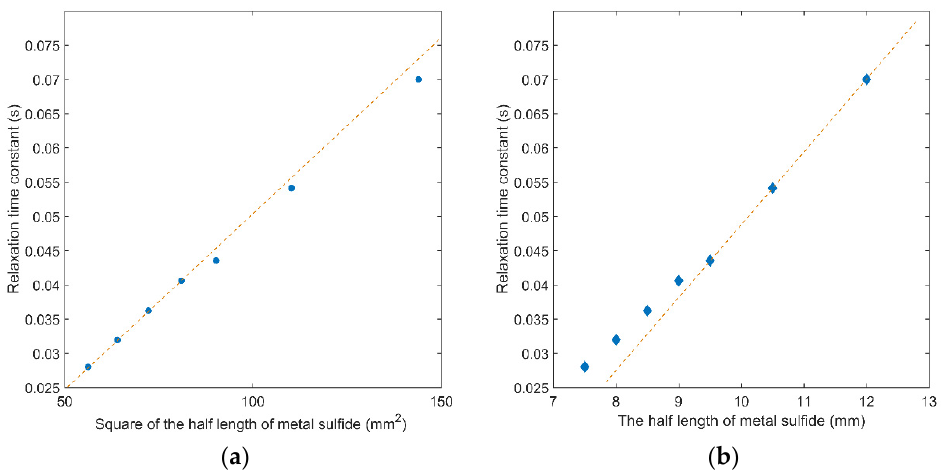
Figure 10. Dependence of relaxation time constants on the square of half of the length and half of the length of seafloor massive sulfides. ( a ) Relaxation time constants versus the squares of half of the lengths. ( b ) Relaxation time constants versus half of the lengths.